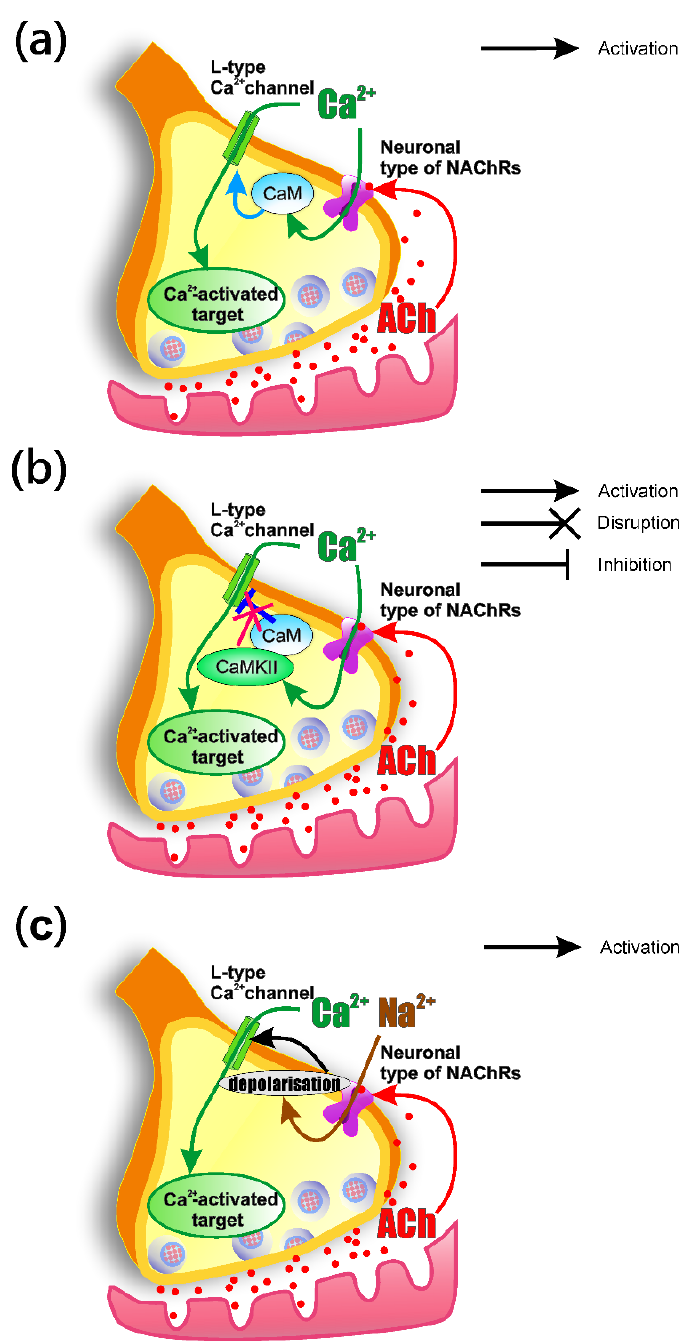
Figure 9. Schematic drawing showing possible mechanisms of the coupling between nAChRs and L-type (Ca v 1) calcium channels in the motor nerve terminal. ( a ) Calcium dependent facilitation of the Ca v 1 type channel, mediated by CaM and triggered by calcium [52], which enters through nNAChRs; ( b ) calcium dependent inactivation process of Ca v 1 type calcium channels, mediated by the interaction between CaM and the Ca 2+ channel, is disrupted by an increase in CaMKII activity [53]; ( c ) opening of Ca v 1 calcium channels and entry of calcium into terminal caused by depolarization due to activation of nAChRs [54].